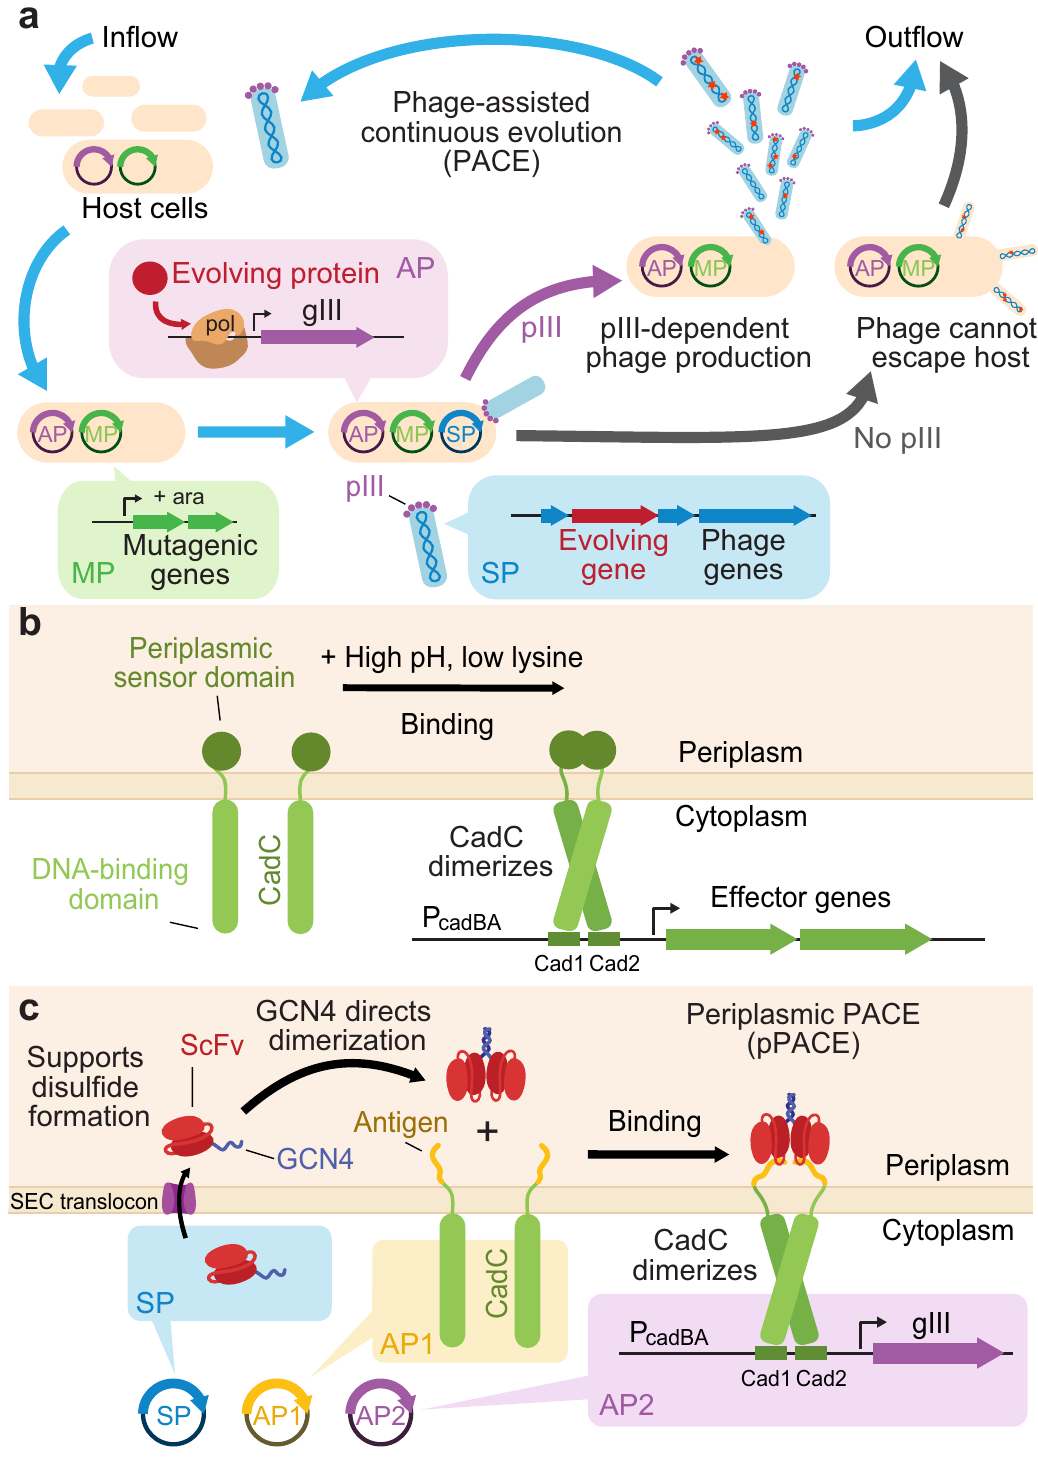
The point mutation V139R blocks YibK dimerization by disrupting hydrophobic interactions between YibK monomers and preventing a fi nal folding transition to the native YibK structure 59,60 . The K D values for dimerization of wild- respectively 60 . The introduction of V139R resulted in